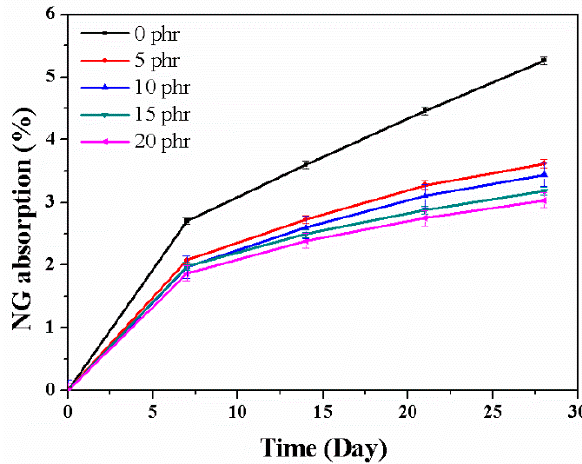
Figure 5. Nitroglycerin adsorption in EPDM/CR nanorubbers with various layered-silicate contents.